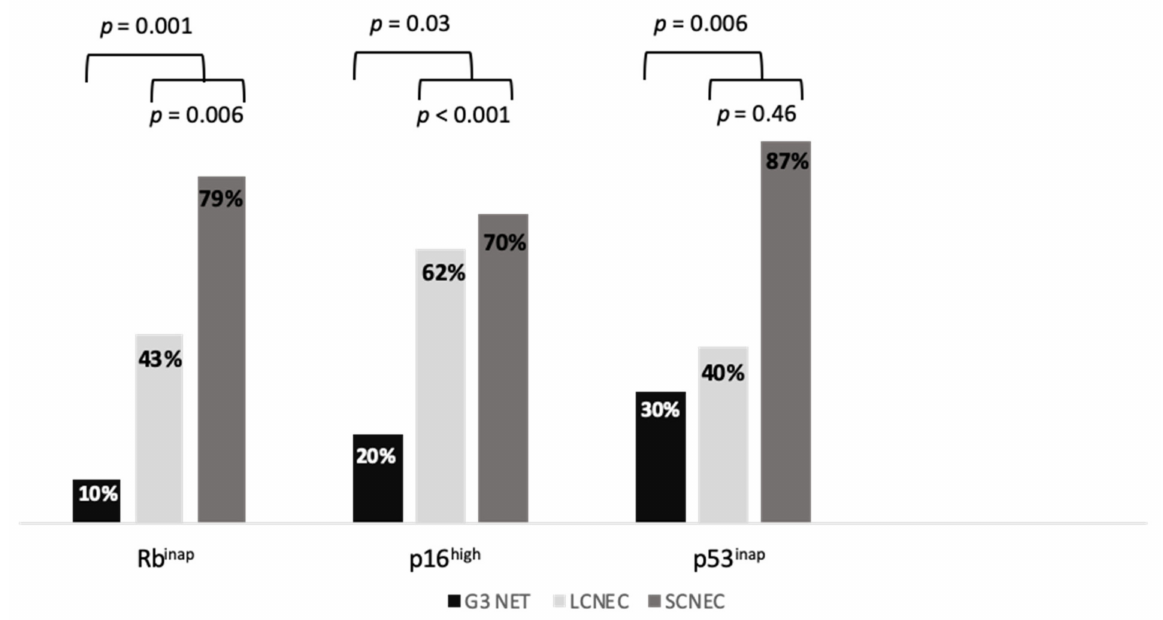
Figure 2. Rb, p53 and p16 status in G3 NET, LCNEC and SCNEC. LCNEC, large-cell neuroendocrine carcinoma; NET, neuroendocrine tumor; SCNEC, small-cell neuroendocrine